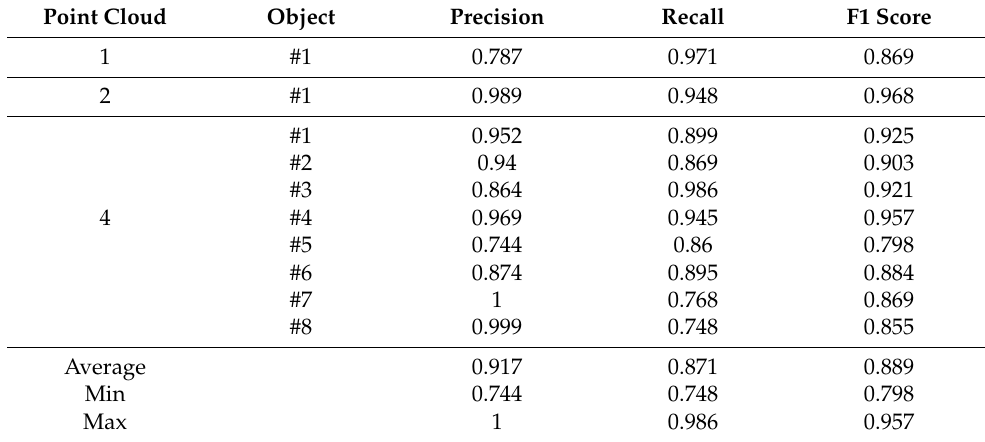
Table 3. Numerical results.